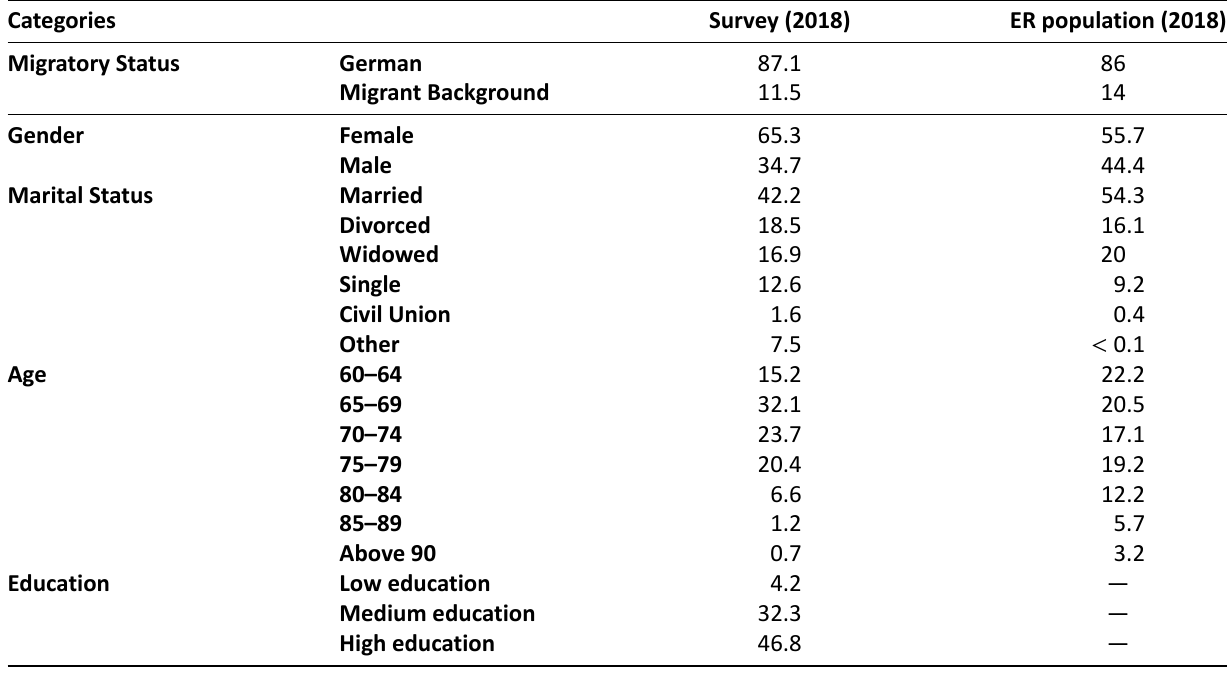
Table 1. Characteristics of the survey population (in